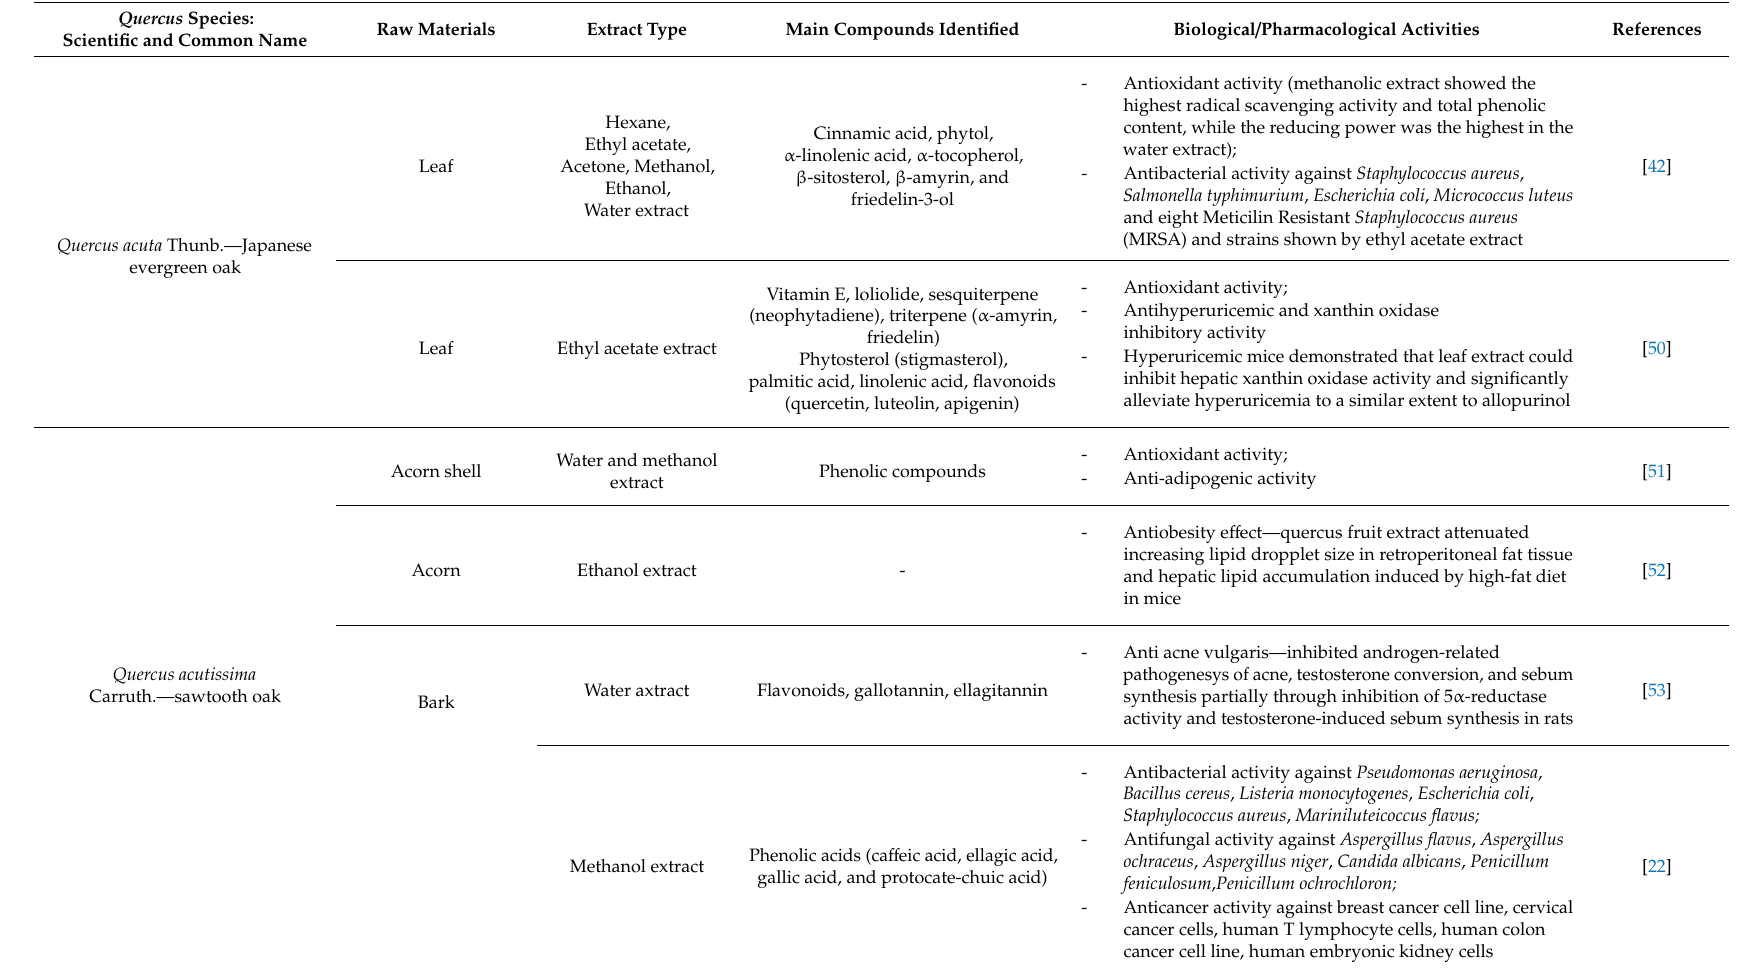
Table 1. The biological activities of natural extracts obtained by Quercus (Fagaceae)